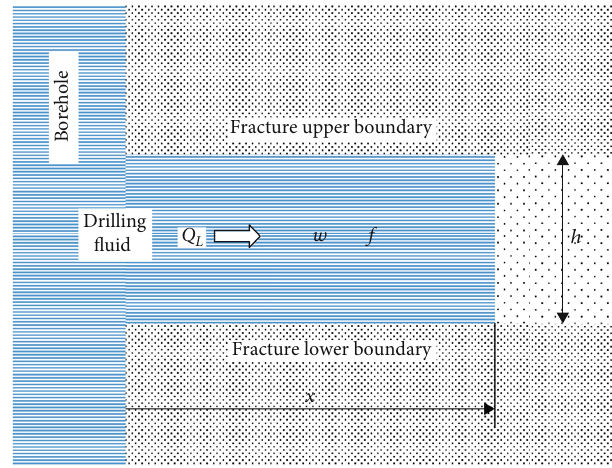
Figure 2: Cross-sectional view of liquid pipe fl ow in a